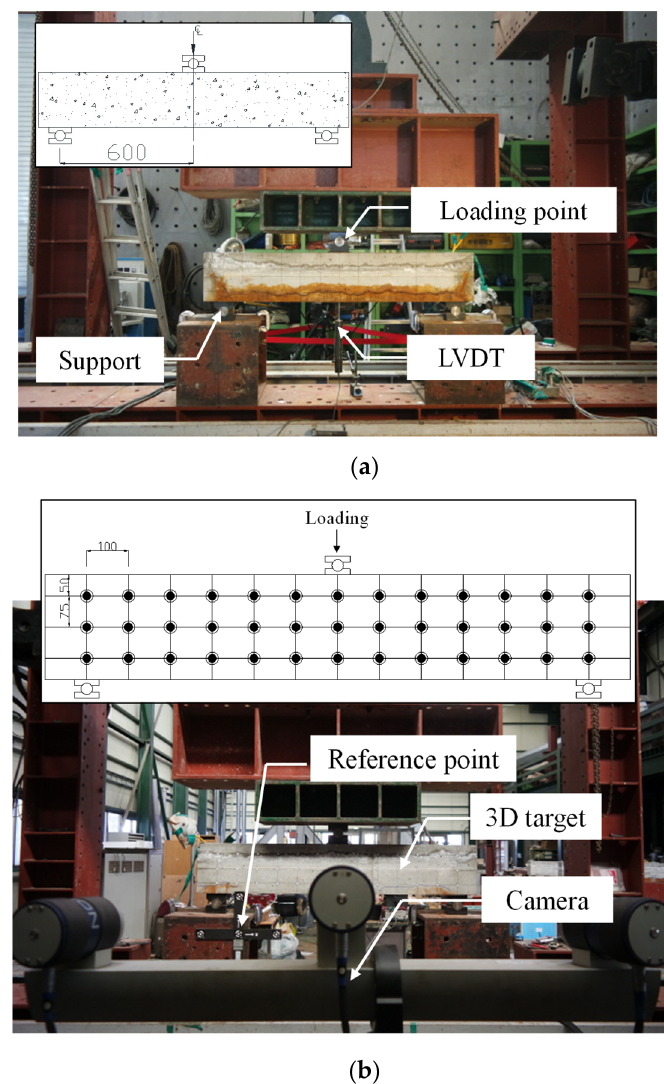
Figure 3. Shear test set-up. ( a ) Test set-up for one-point loading; ( b ) Image-based displacement measurement system.